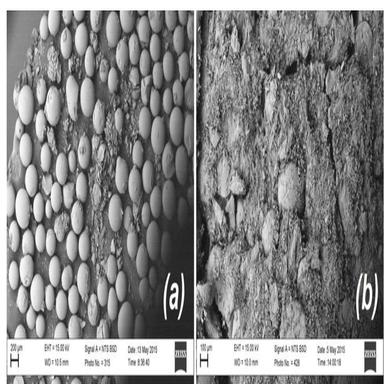
Micrographs of the solid glass microspheres after the encapsulation tests for the configuration B setup with scale mark of 200 μm (a) and for the configuration A setup with scale mark of 100 μm (b).